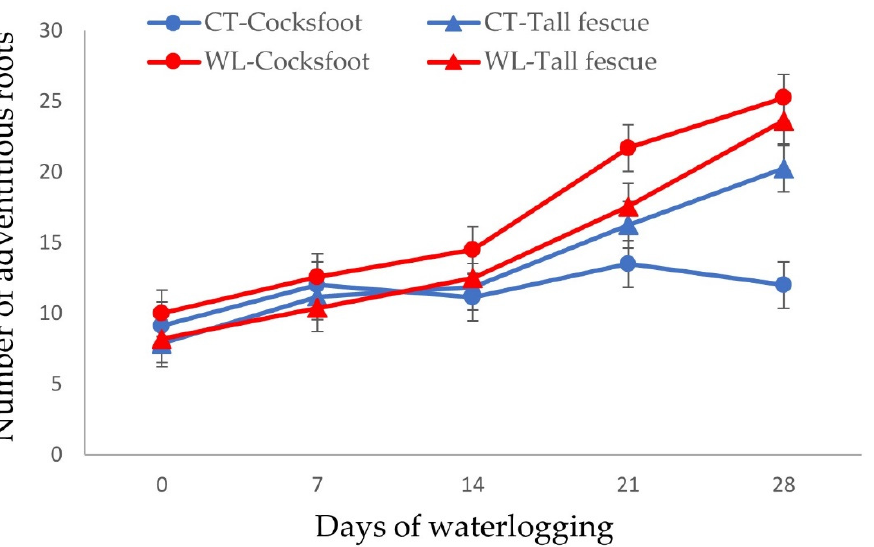
Figure 2. Number of adventitious roots of cocksfoot and tall fescue at different stages of treatment under both control (CT) and waterlogging (WL) conditions. Values given are least squares means of four replicates and error bars indicate 95% confidence intervals of the least squares means.